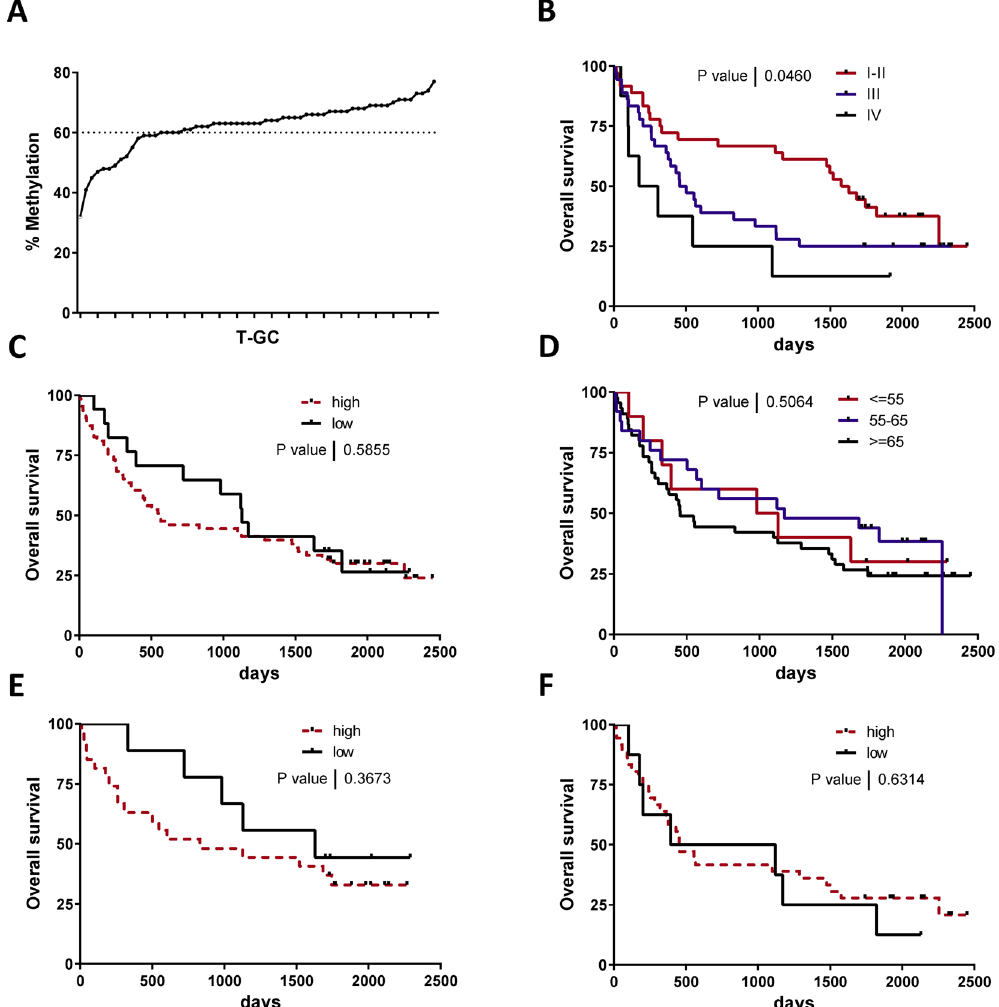
Figure 5. Overall survival analyses of patients with GC based on LINE-1 methylation. ( A ) Patients with GC with high and low LINE-1 methylation status defined by cut-off 60% based on LINE-1 methylation in T-GC sample (low LINE-1 methylation 21.5%). ( B ) Kaplan-Meier analyses based on UICC tumor stage with significant surivival difference among the groups. ( D ) Kaplan-Meier analyses based on high (n = 63) and low (n = 17) LINE-1 methylation status (cut-off methylation 60%) (p = 0.59). ( D ) Kaplan-Meier analyses based on high ≥ 65% (n = 45), middle > 55% and < 65% (n = 25) and low ≤ 55% (n = 10) LINE-1 methylation status (p = 0.51). ( E ) Kaplan-Meier analyses of survival difference based on LINE-1 methylation status in intestinal/ mixed type GC (p = 0.36) and in ( F ) diffuse type GC (p = 0.63). Statistical comparison between curves was performed with Log-rank (Mantel-Cox)